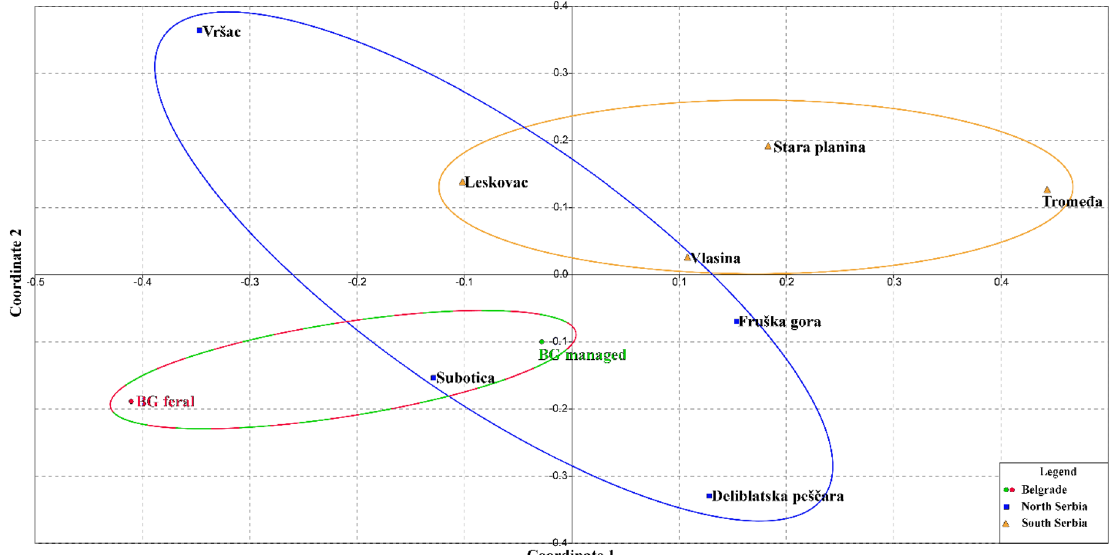
Figure 2. Non-metric multidimensional scaling plot of F ST distances between two types of honey bee colonies from Belgrade and honey bee colonies originating from different regions of Serbia based on the variability of 14 microsatellite loci. The goodness of fit is expressed with the stress value, which is 0.1909 for this data set. Population pairwise F ST values are presented in Suppl. Table